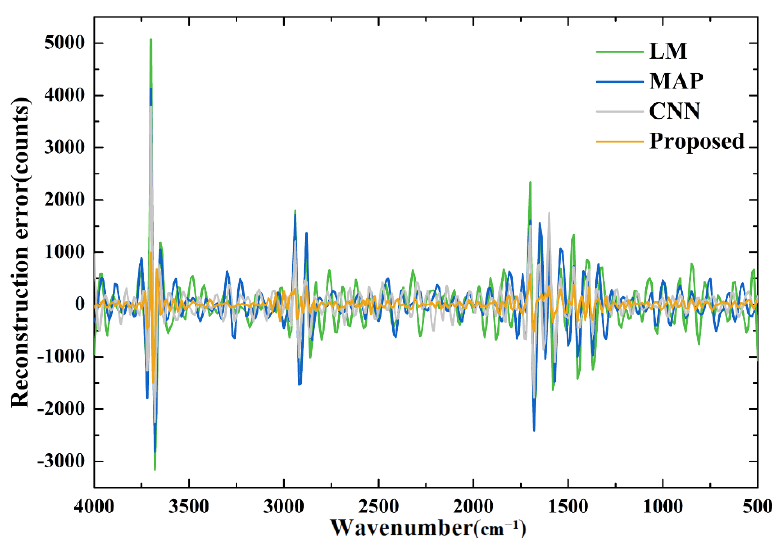
Figure 7. Reconstruction errors of the Raman spectrum by several methods.